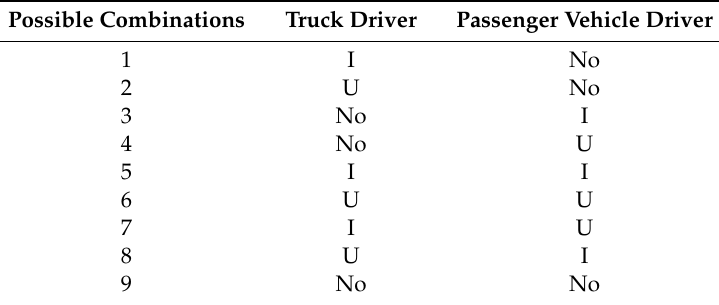
Table 1. Combinations of di ff erent driver